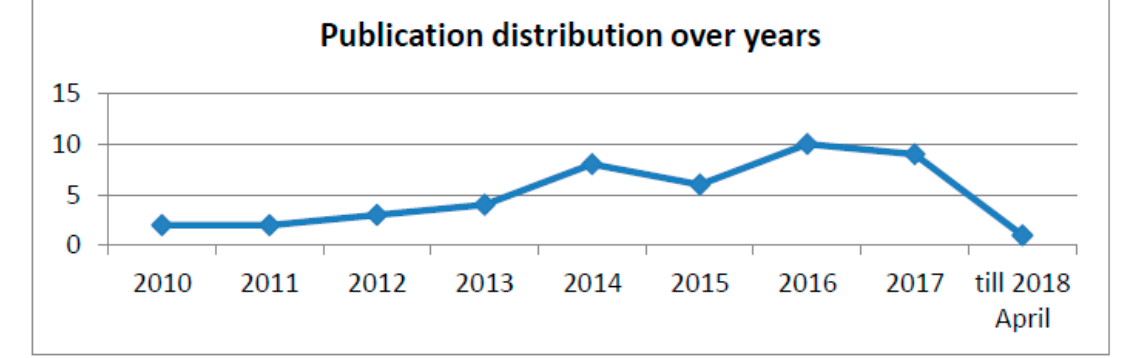
Figure 11. Publications distribution over years.